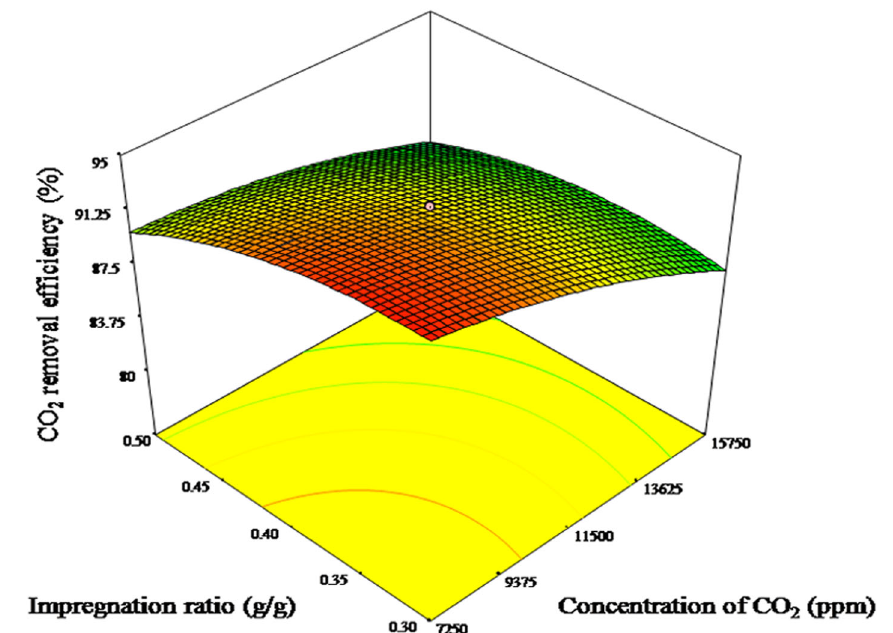
Fig. 7 Combined effect of impregnation ratio and initial concentration of CO 2 on CO 2 removal efficiency (%) at weir height 40